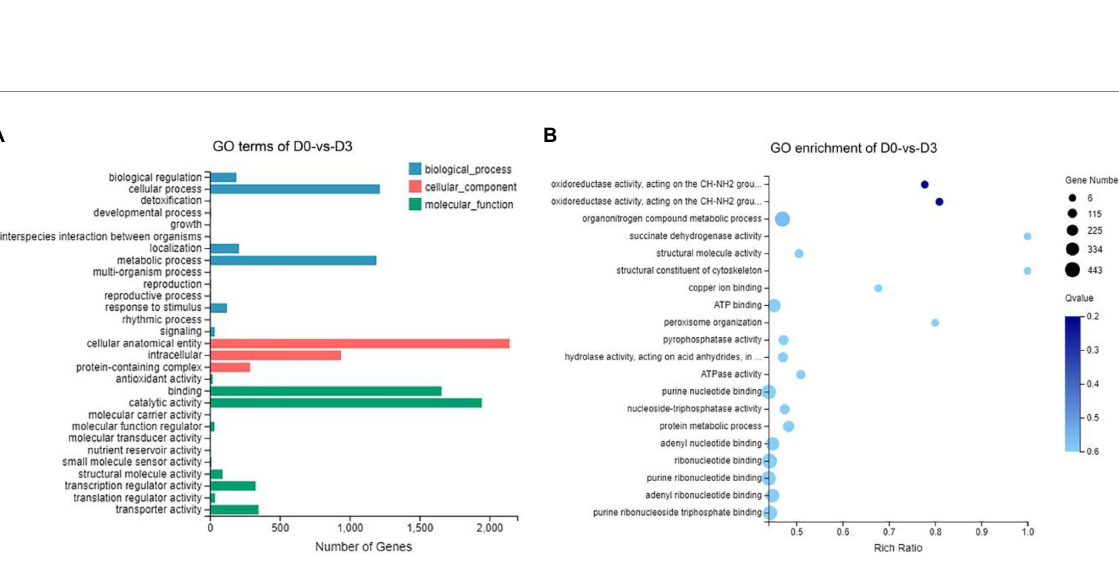
FIGURE 8 GO analysis of DEGs during the fermentation of D0- vs -D3. (A) The GO terms analysis and (B) GO enrichment analysis of top 20 with the smallest Q